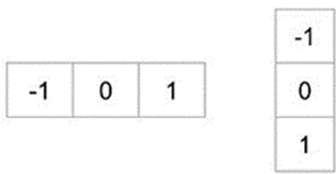
The density changes of an image in x- and y-axis (edges and corner) become apparent with the gradient of the image. Gradient images of a sample image on the x- and y-axis are given in Figure 2. It can be observed that the gradient on the x-axis makes the vertical lines clear, while the gradient on the y-axis makes the horizontal lines clear.